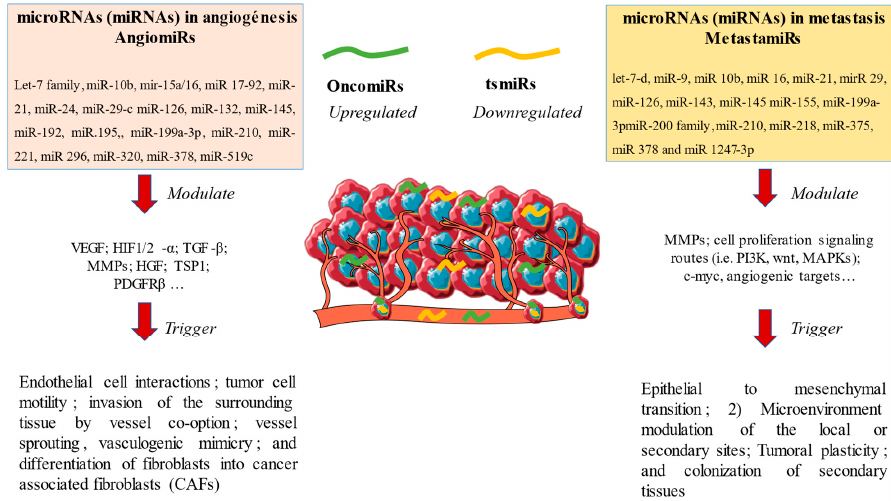
Figure 2. A general overview of the role of microRNAs in angiogenesis and metastasis. In this picture, different alterations in the up- or downregulation of oncogenic (OncomiRs) and onco-suppressive (tsmiRs) microRNAs cause alterations that lead to a stimulation of different mechanisms of angiogenesis and metastasis. Table 3. MetastamiRs and their expression and role in metastasis.